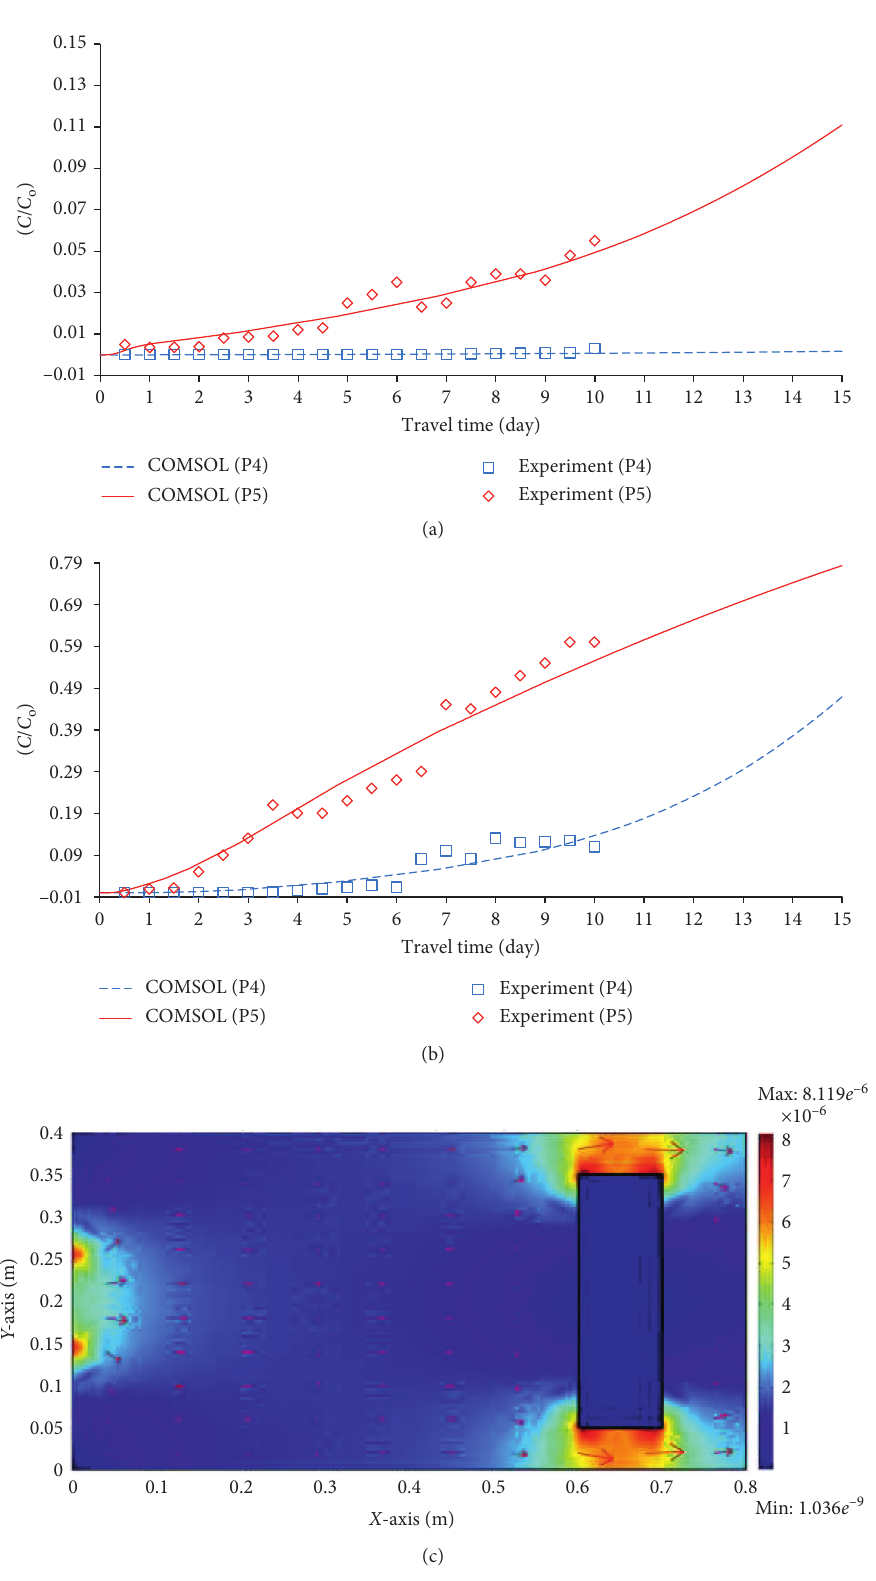
Figure 5: Comparison between COMSOL solution and experimental results for (a) Pb +2 and (b) Ni +2 normalized concentrations in the presence of WFS as LPB for distribution of (c) velocity